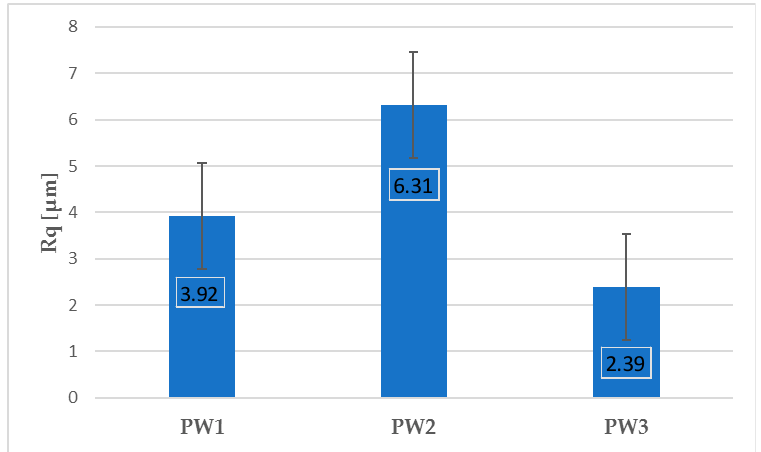
Figure 7. Comparison of the maximum height of surface roughness (Rq) of PW1, PW2, and PW3 samples.